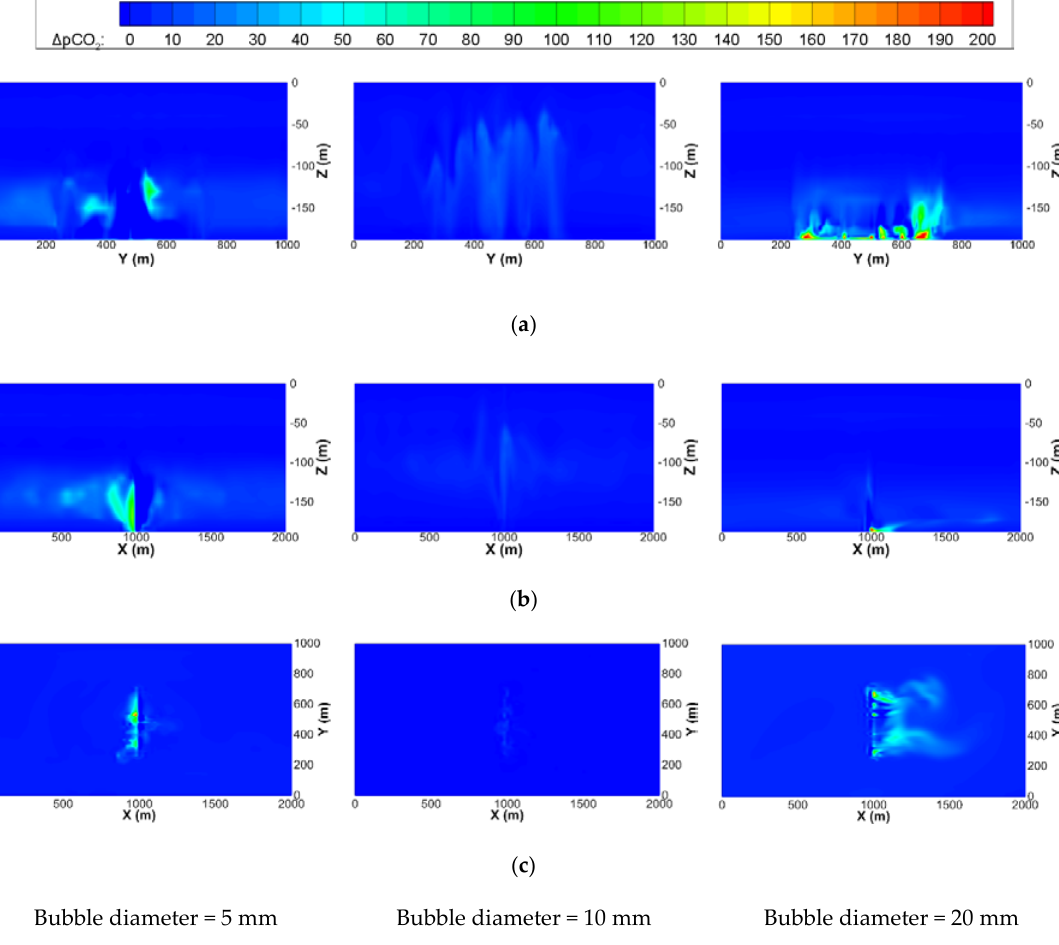
Figure 12. Contour maps of ∆ pCO 2 on the center planes of the x, y, and z directions of the small-scale domain at 30 days after the start of leakage with the same leakage rates of 100,000 t / y and leakage area of 20,000 m 2 but di ff erent initial diameters of the bubble. ( a ) Center plane in x direction (x = 1000 m); ( b ) Center plane in y direction (y = 500 m); ( c ) xy plane near leakage area (z = − 180